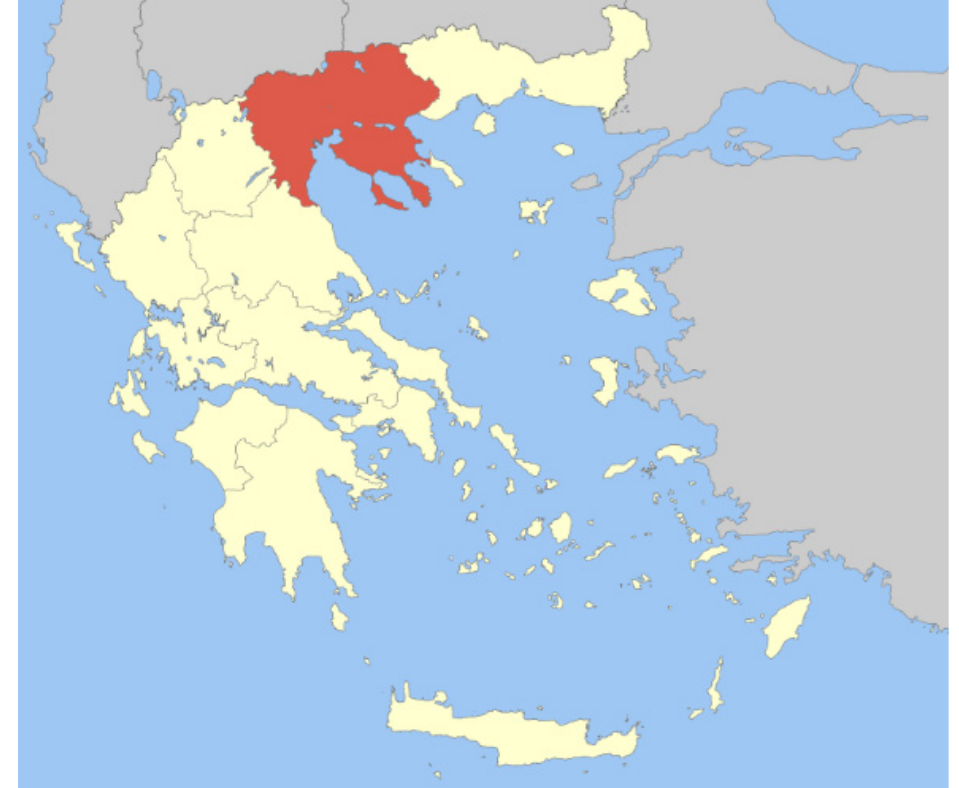
Figure 1. The region of Central Macedonia. Source: Wikipedia.